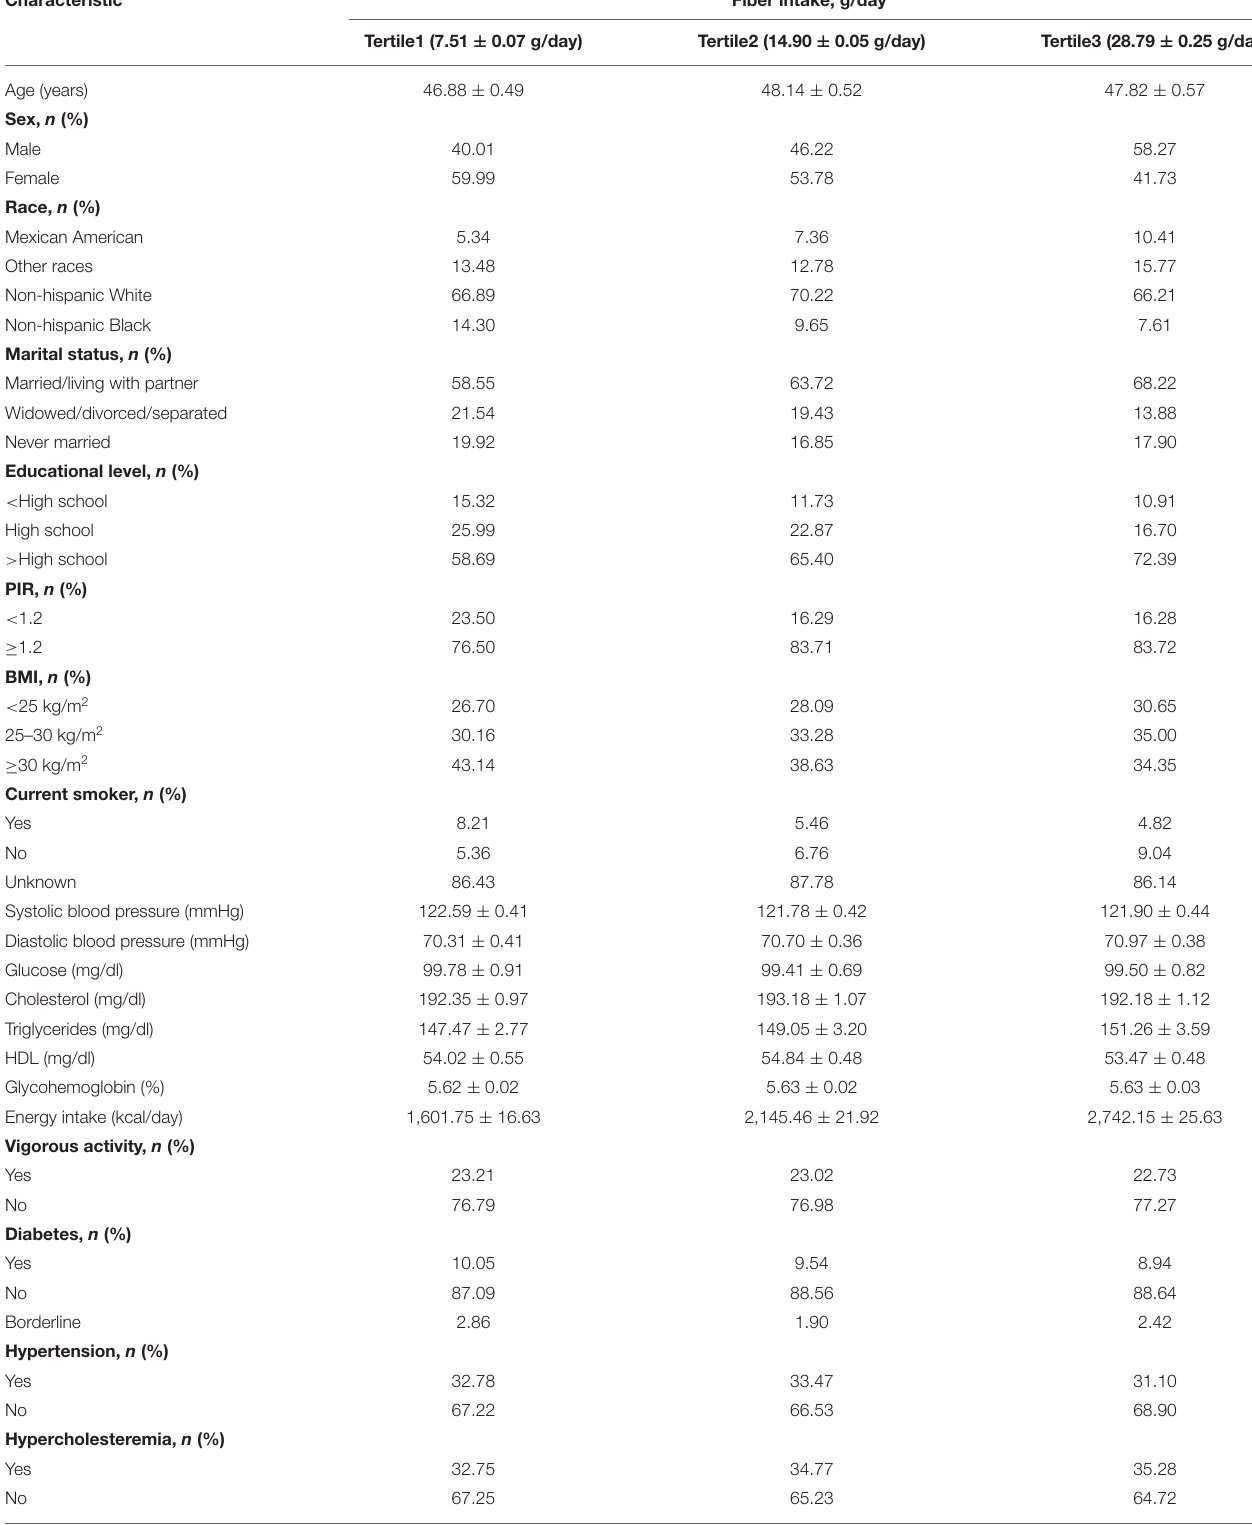
TABLE 1 | Baseline characteristics of the participants, weighted.